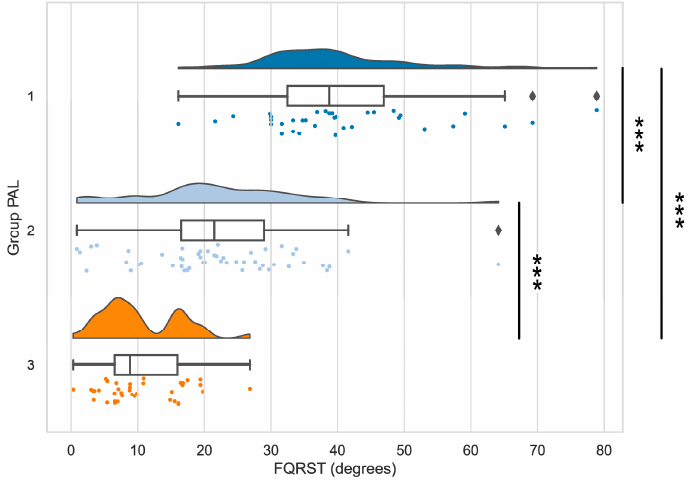
Figure 1. The distributions of FQRST data depending on the PAL level. Note—Stars indicate significant differences ( p < 0.001) for the comparisons of FQRST between PAL groups 1 and 2, 2 and 3, 1 and 3, respectively (Mann-Whitney tests).